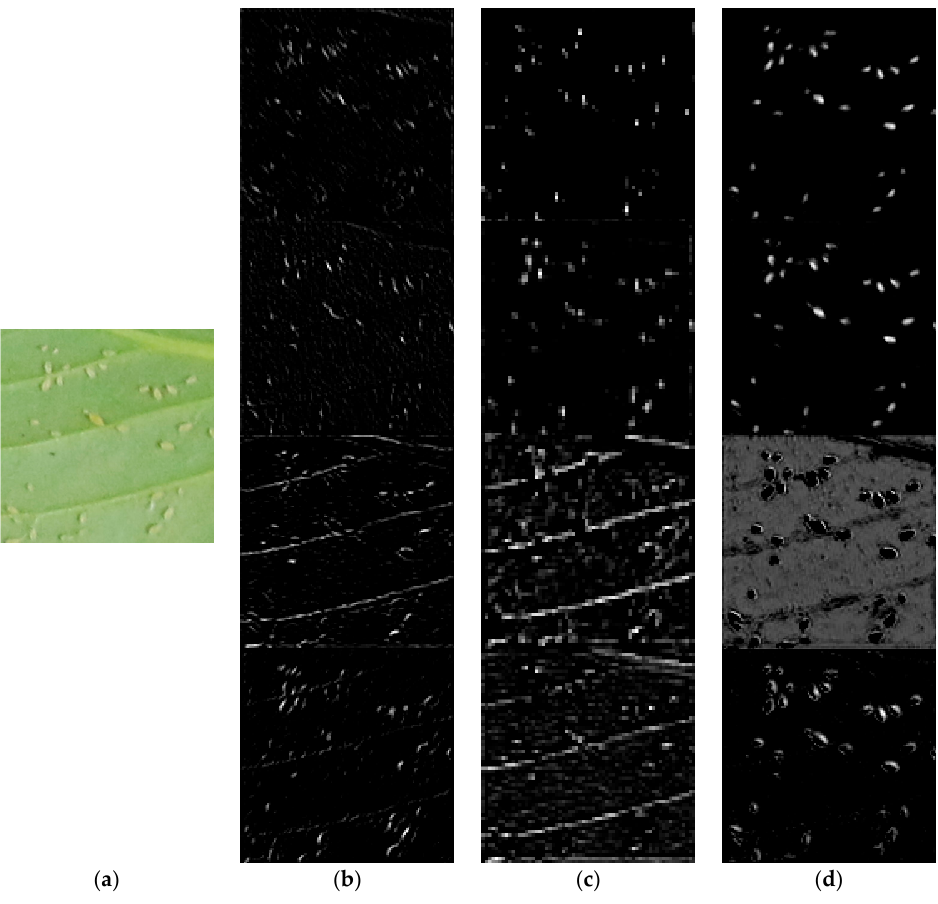
Figure 6. Representative feature maps of CNN-4-4. The four columns are: ( a ) the input image; ( b ) feature maps of the second contracting block; ( c ) feature maps of the third contracting block; ( d ) feature maps of the third expanding block.